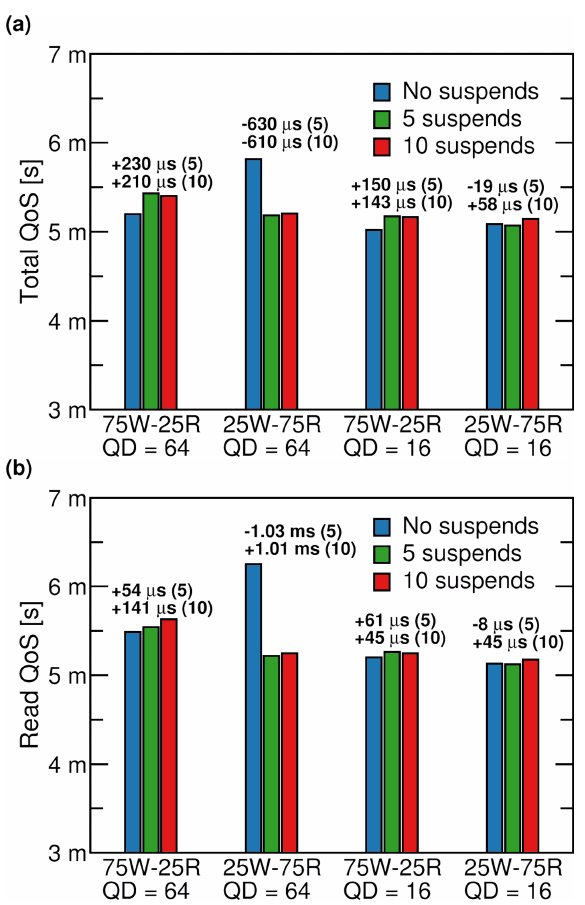
Figure 13. ( a ) The total QoS. ( b ) The read QoS. Both metrics were extracted at the 99.99-percentile of the latency